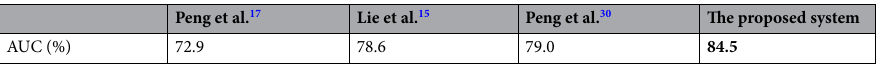
Table 13. The comparison between our proposed system and some current systems based on AUC. Significant value is in bold.